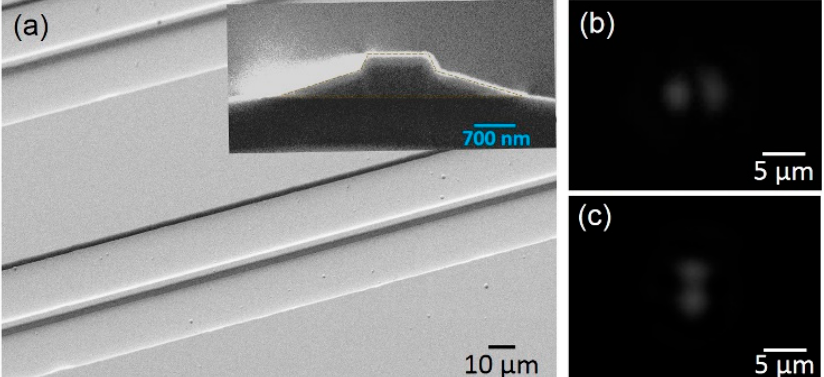
Figure 2. (a) Scanning-electron-microscope (SEM) images of lithium niobate (LN) waveguide before coating the Ta 2 O 5 cladding layer) showing very smooth sidewalls. Inset: waveguide cross-section. Spatial distributions of (b) transverse-electric (TE) and (c) transverse-magnetic (TM) modes.